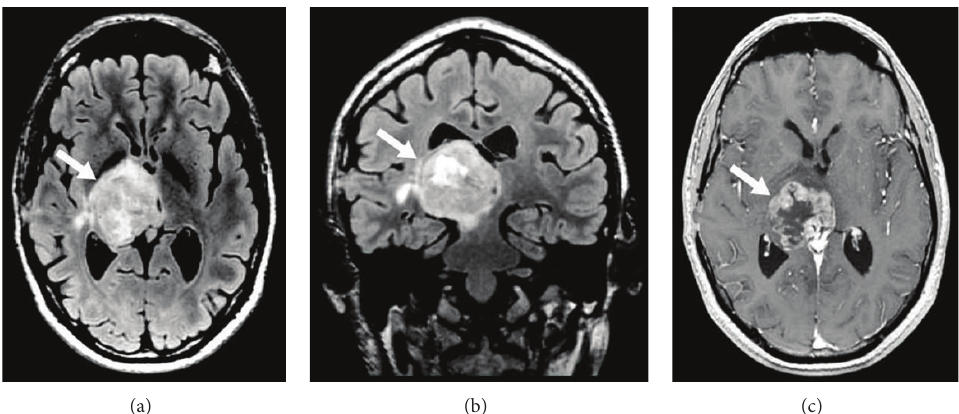
Figure 17: A patient with glioblastoma multiforme in the right thalamus seen as hyperintensity on axial (a) and coronal (b) FLAIR imaging, with gadolinium-enhancement on axial T1-weighted imaging (c).